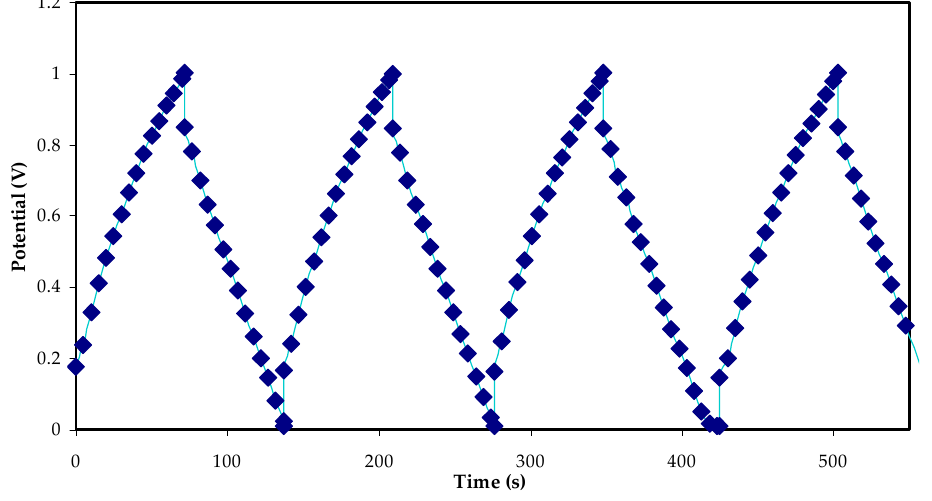
Figure 15. The GCD side view of the EDLC.